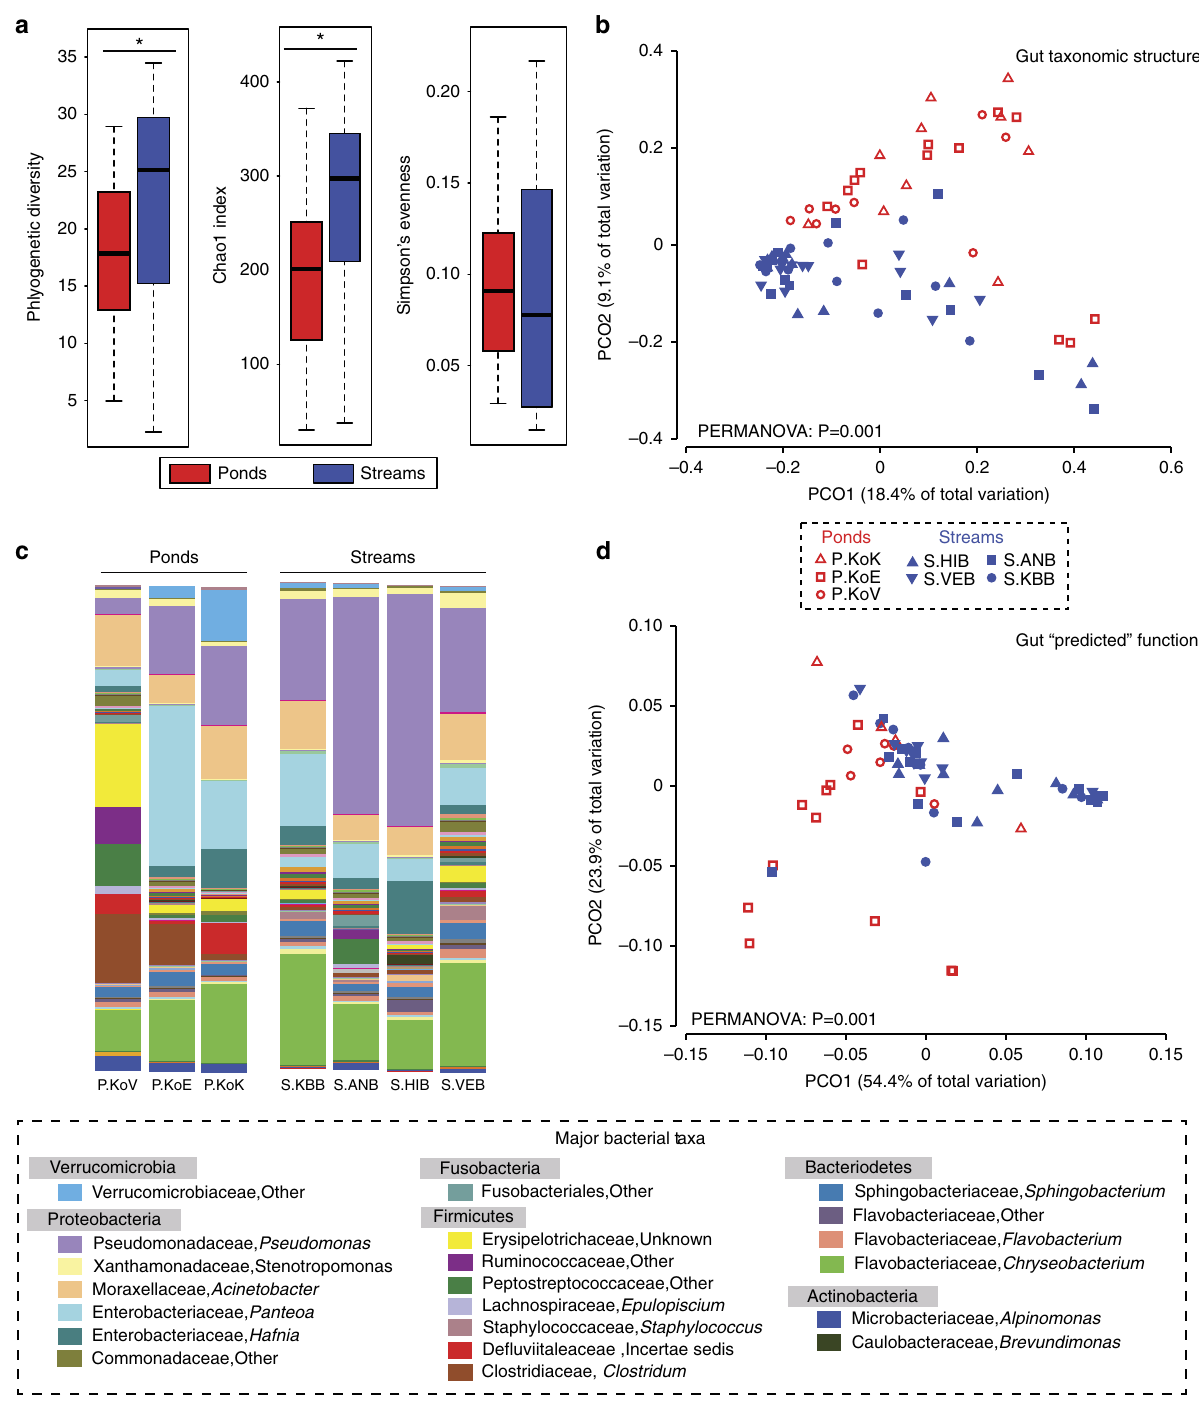
Figure 1 | Pond and stream larvae exhibit distinct gut microbiota and predicted functions. ( a ) Alpha diversity between pond and stream larvae for Phylogenetic Diversity and Chao1 and Simpson’s Evenness Index. Asterisks denote statistically significant differences as determined by Kruskal–Wallis tests. ( b ) Principal Coordinates Analysis of unweighted Unifrac distance matrix showing separation of pond and stream larva gut communities. Main-effect PERMANOVA results are displayed. Permutational test of dispersions (PERDISP) showed no differences in dispersion between pond and stream communities (F (1,75) ¼ 0.3161, P ¼ 0.625). ( c ) Mean relative abundance profiles of Core50 gut bacterial taxa (#OTUs ¼ 82) at the genus level from four stream sites and three pond sites. Dominant taxa are identified in the legend. ( d ) PCo analysis of predicted functional profiles of gut bacterial communities from the field survey. Sample sizes were: n ¼ 46 (streams); n ¼ 31 (ponds). Pond larvae are shown in red and stream larvae are shown in blue in panels ( a , b and d abundance between pond and stream larvae. The most dominant Firmicutes (pond: 41.3%, stream: 10.7%), Bacteroidetes (pond: taxa were Proteobacteria (Alpha-pond: 4.9%, stream: 7.0%; Beta- 14.1%, stream: 20.1%), Actinobacteria (pond: 3.9%, stream: 6.6%) pond: 2.3%, stream: 3.0%; Gamma-pond: 23.1%, stream: 50.9%), and Verrucomicrobia (pond: 6.7%, stream: 1.4%). These groups